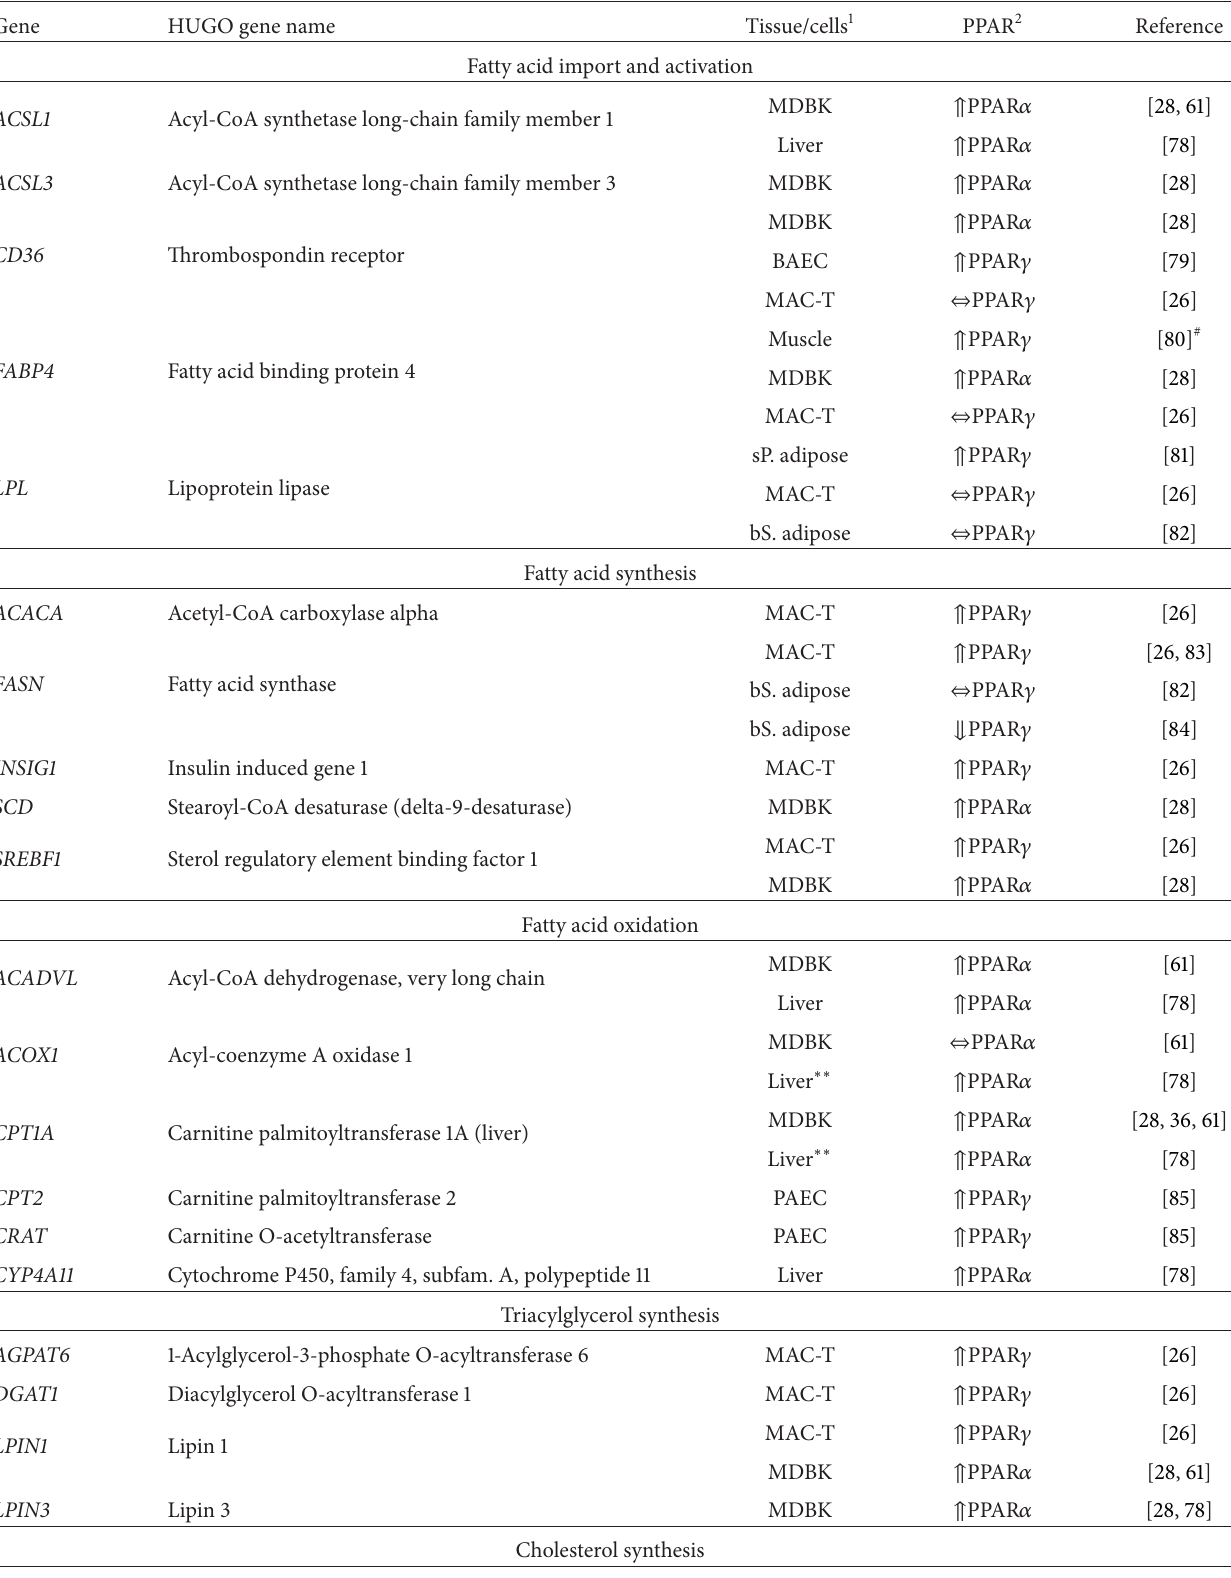
Table 2: PPAR isotype target genes in ruminants grouped by main biological